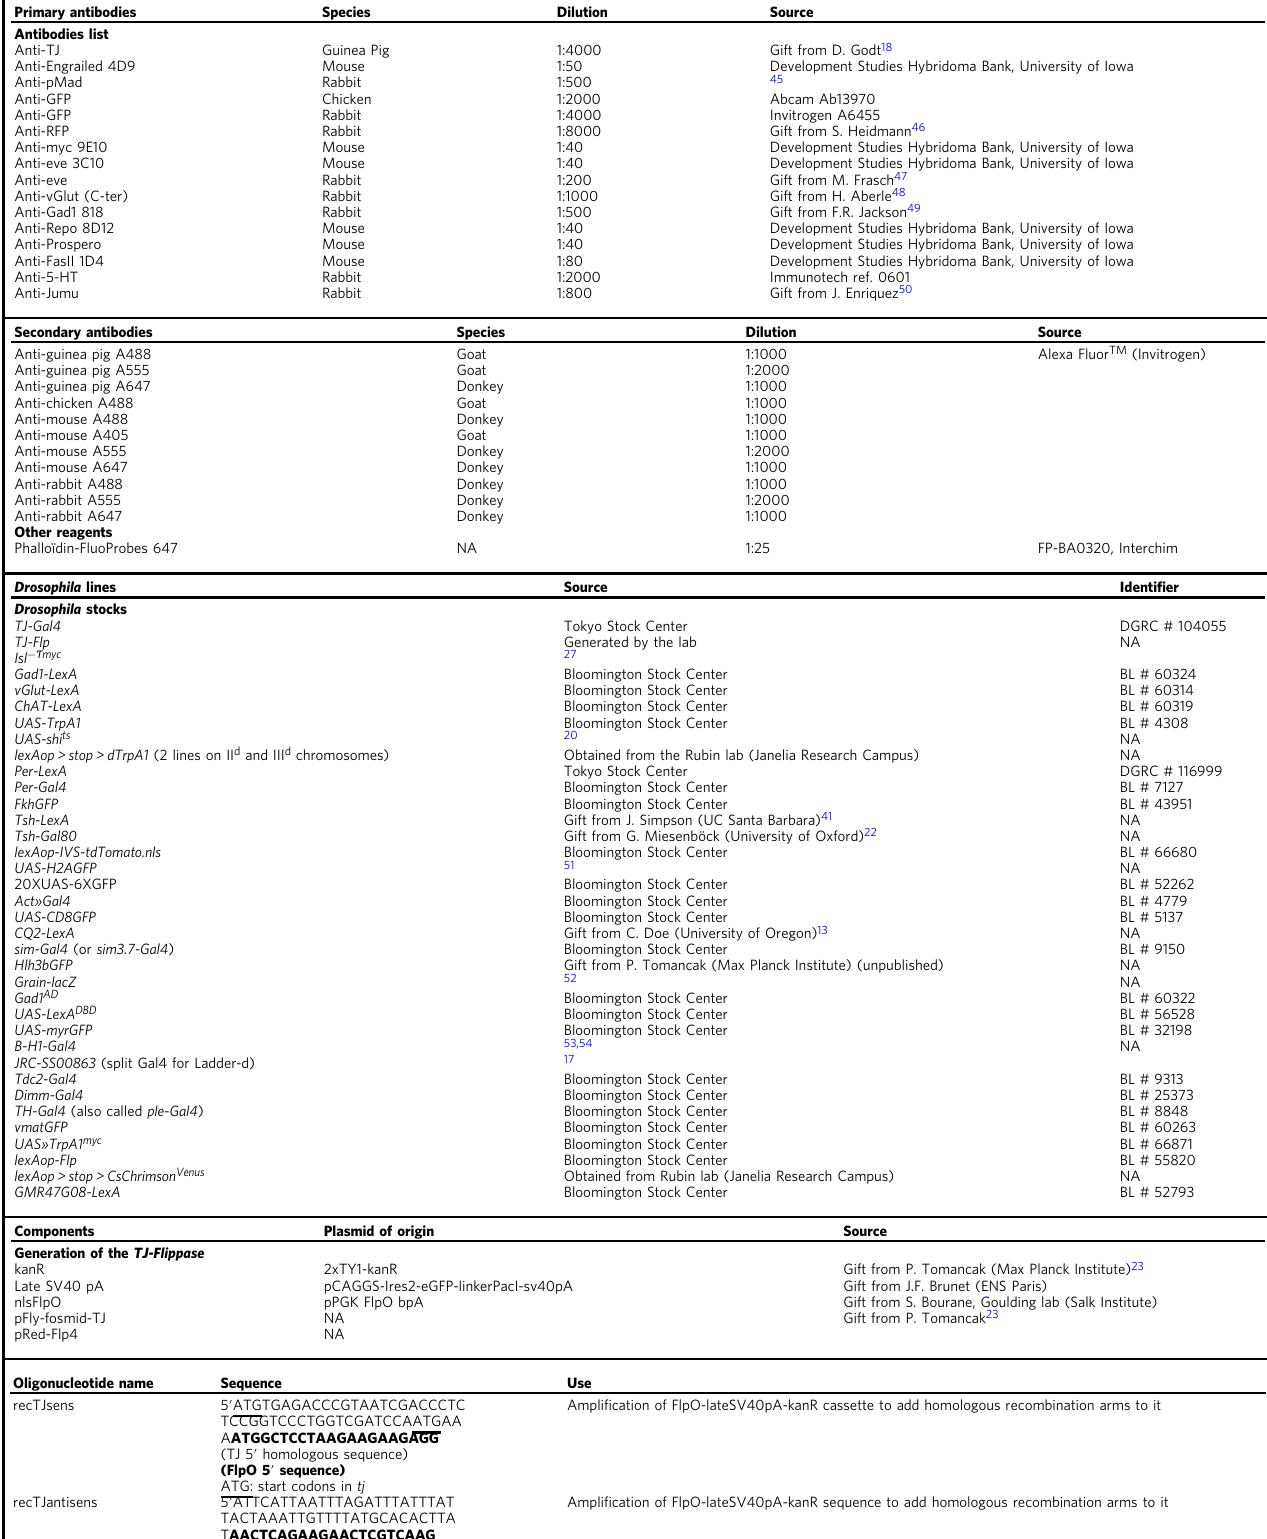
Table 1 List of antibodies, Drosophila lines, oligonucleotides and reagents used in this study Primary antibodies